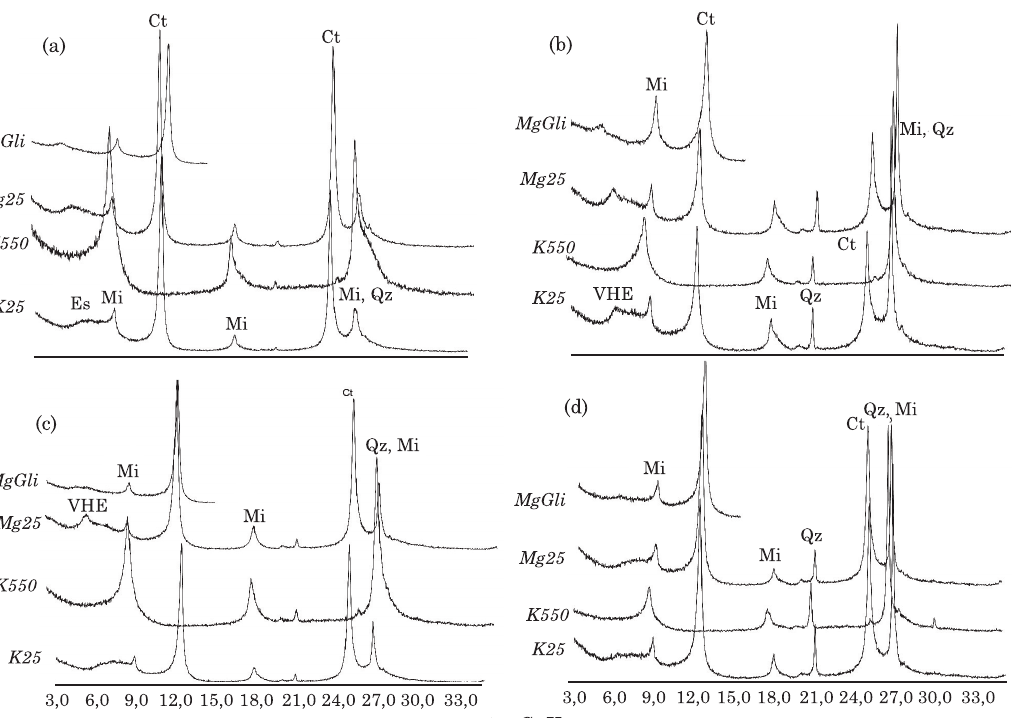
Figura 2. Difratogramas da fração argila do horizonte Bt: (a) perfil P06 (Cambissolo); (b) perfil P19 (Planossolo); (c) perfil 31 (Plintossolo); (d) perfil 33 (Gleissolo). Lâminas saturadas por K+ e Mg 2+ a 25 o C (K25; Mg25), glicoladas (MgGli) e calcinadas a 550 o C (K550). Mi: mica; Qz: quartzo; Ct: caulinita; VHE: vermiculita com hidróxi-Al entre camadas; e Es: